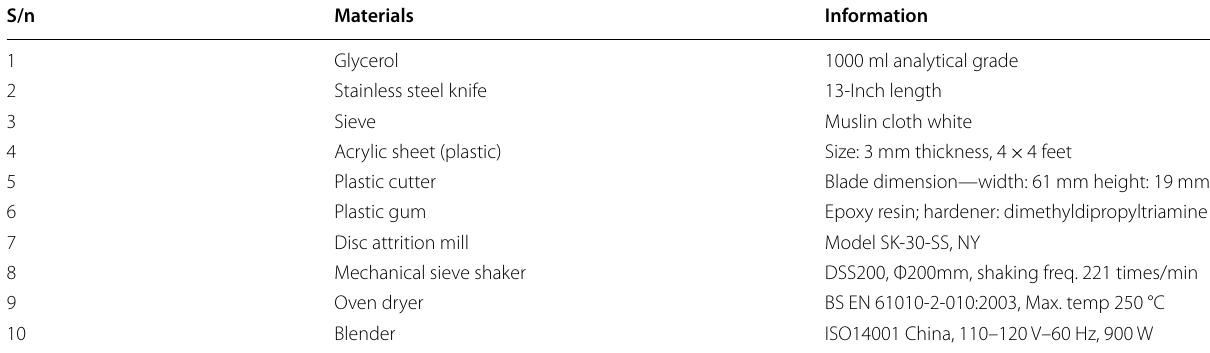
Table 1 List of materials for nanocomposite film development S/n